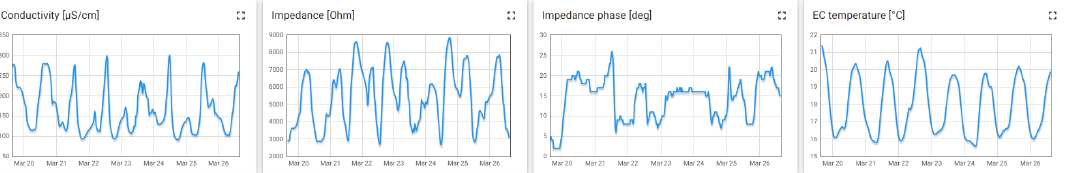
Figure 10. EC reading